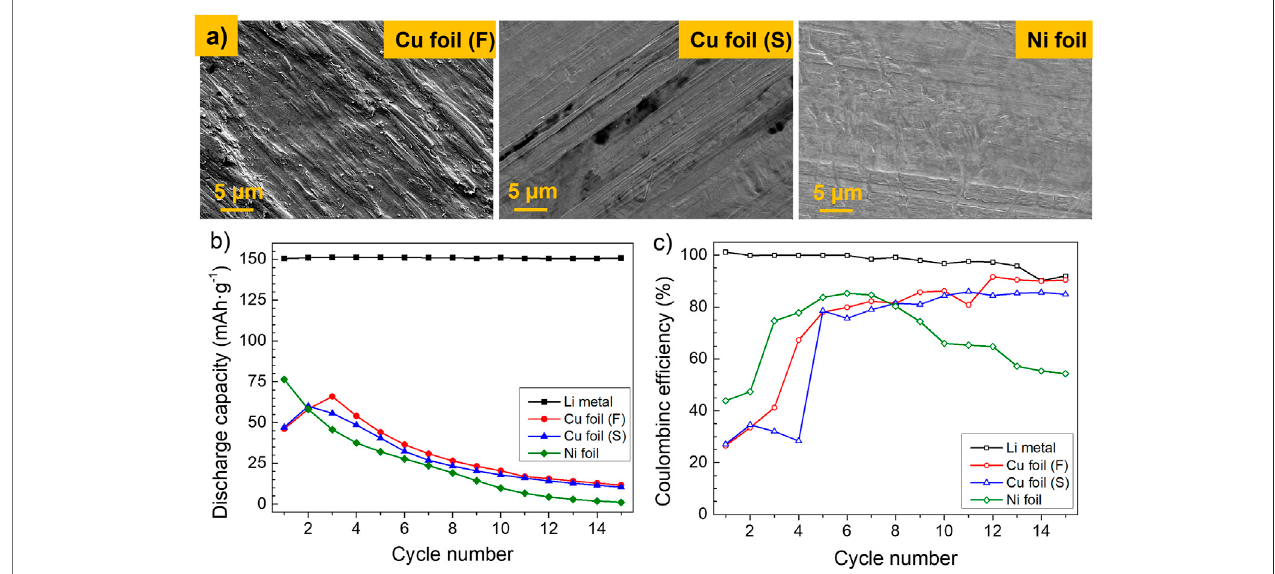
FIGURE 1| (A) FE-SEM micrographs of different investigated anode current collectors, (B) discharge capacity, and (C) Coulombic ef fi ciency ofsingle-layer pouch cells using such anode current collectors. Cycling conditions: 60 ° C, 1 N m, DoD 100%, 2.5 – 3.8 V, 0.1C – 0.1C, and charge cut off current 0.05C.